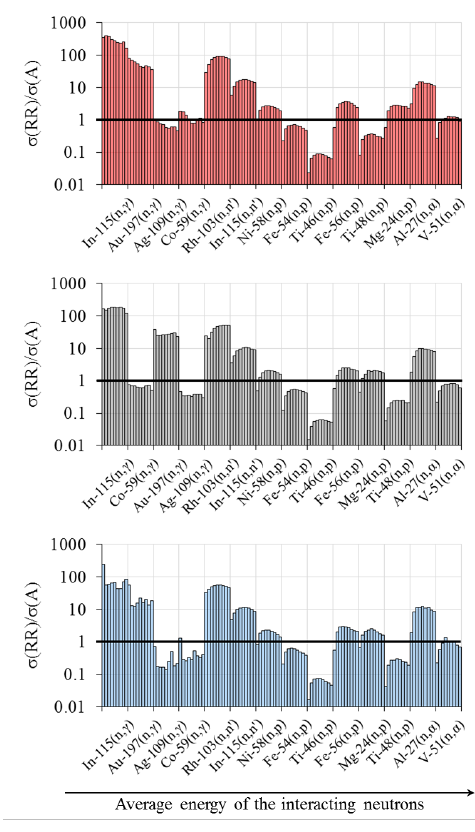
Fig. 4. Ratio of reaction rates ’ distributions in the elemental reflectors (Fe, Cr and Ni top to bottom), over uncertainties on activity determination for all considered reactions sorted by lethargy-averaged neutron energy, and for each reaction sorted by dosimeter